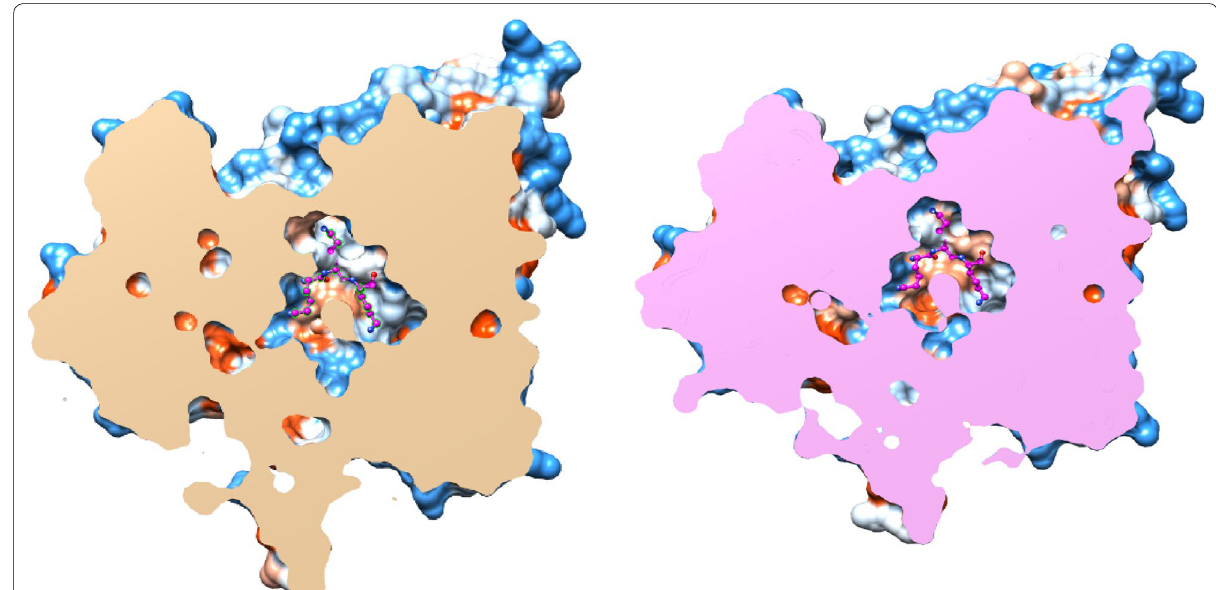
Fig. 2 Insight view into the protein cavities of OppA in open and closed states (left/right PDB codes: 3TCG/2Z23 from E. coli / Y. pestis ) to distinguish the conformational rearrangements. The tri-lysine ligand (from PDB code: 2Z23) was also merged into the other binding site (of PDB code: 3TCG, central hole). Color code for protein surface: bluish/white7redish for positive/neutral/negative partial atom charges,